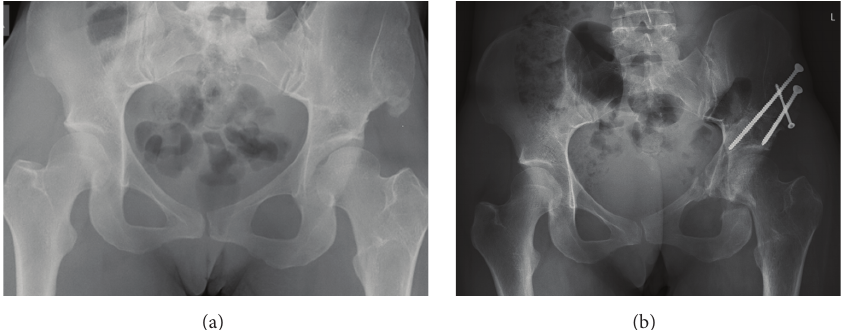
Figure 1: (a) AP pelvic X-ray demonstrating acetabular dysplasia of the left hip. (b) Normalisation of the CEA and healing of the osteotomy sites 3 months after periacetabular